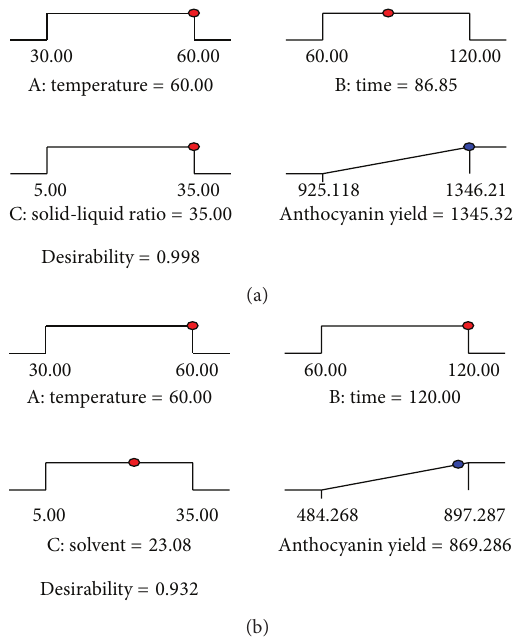
Figure 4: Desirability ramp of optimization for (a) methanolic extraction and (b) ethanolic